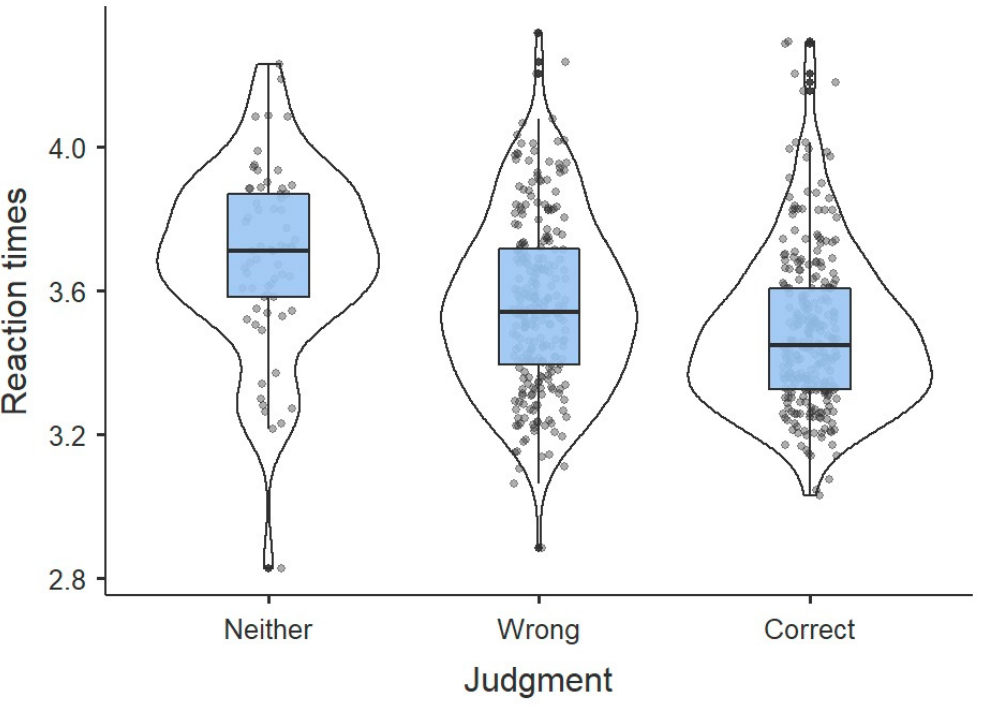
Figure 3. Log-transformed reaction times across groups split for judgment.